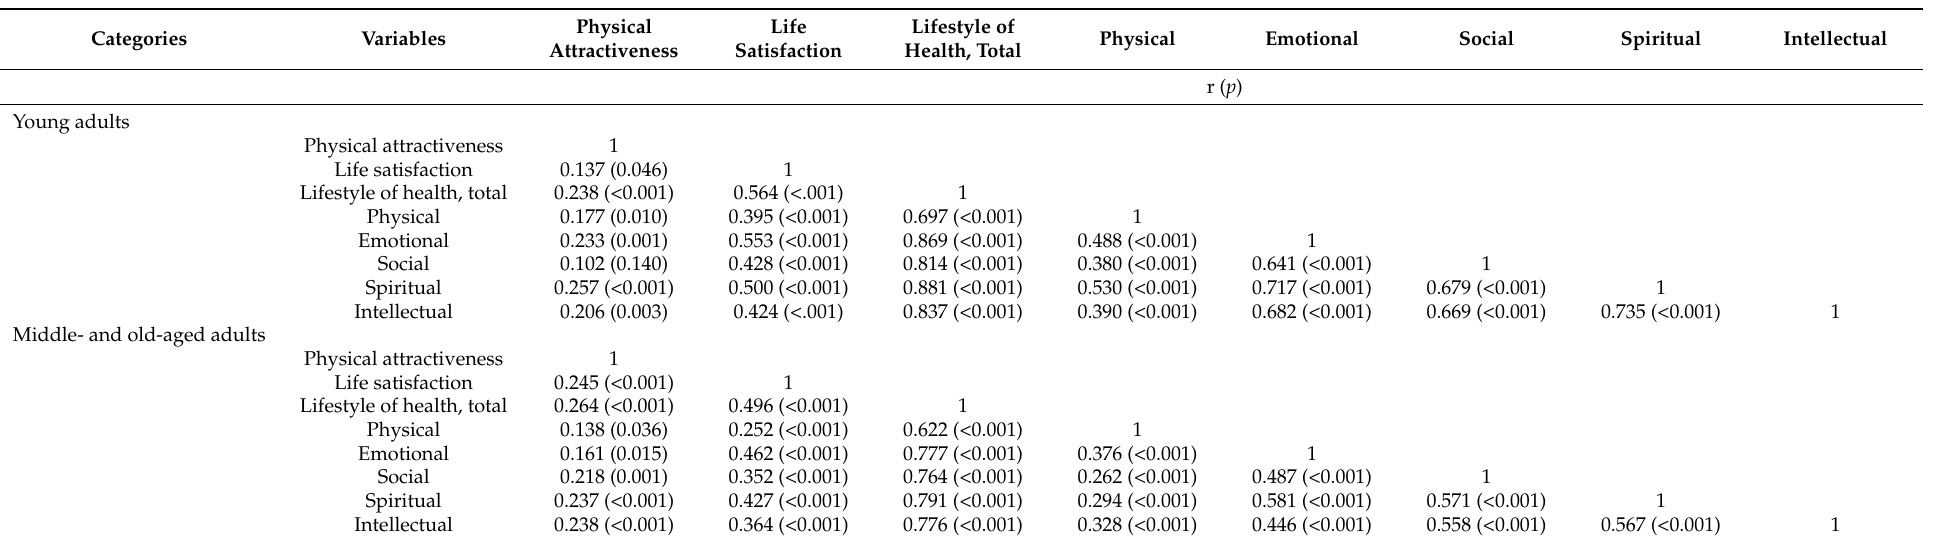
Table 2. Partial correlation coefficients for physical attractiveness, life satisfaction, and lifestyle of health (N =